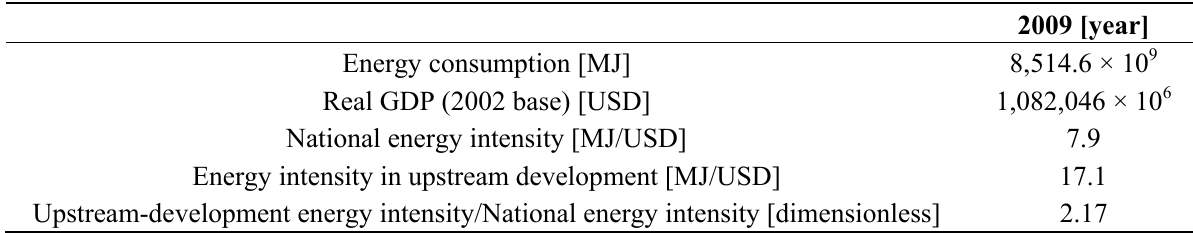
Table 9. Canadian energy intensities